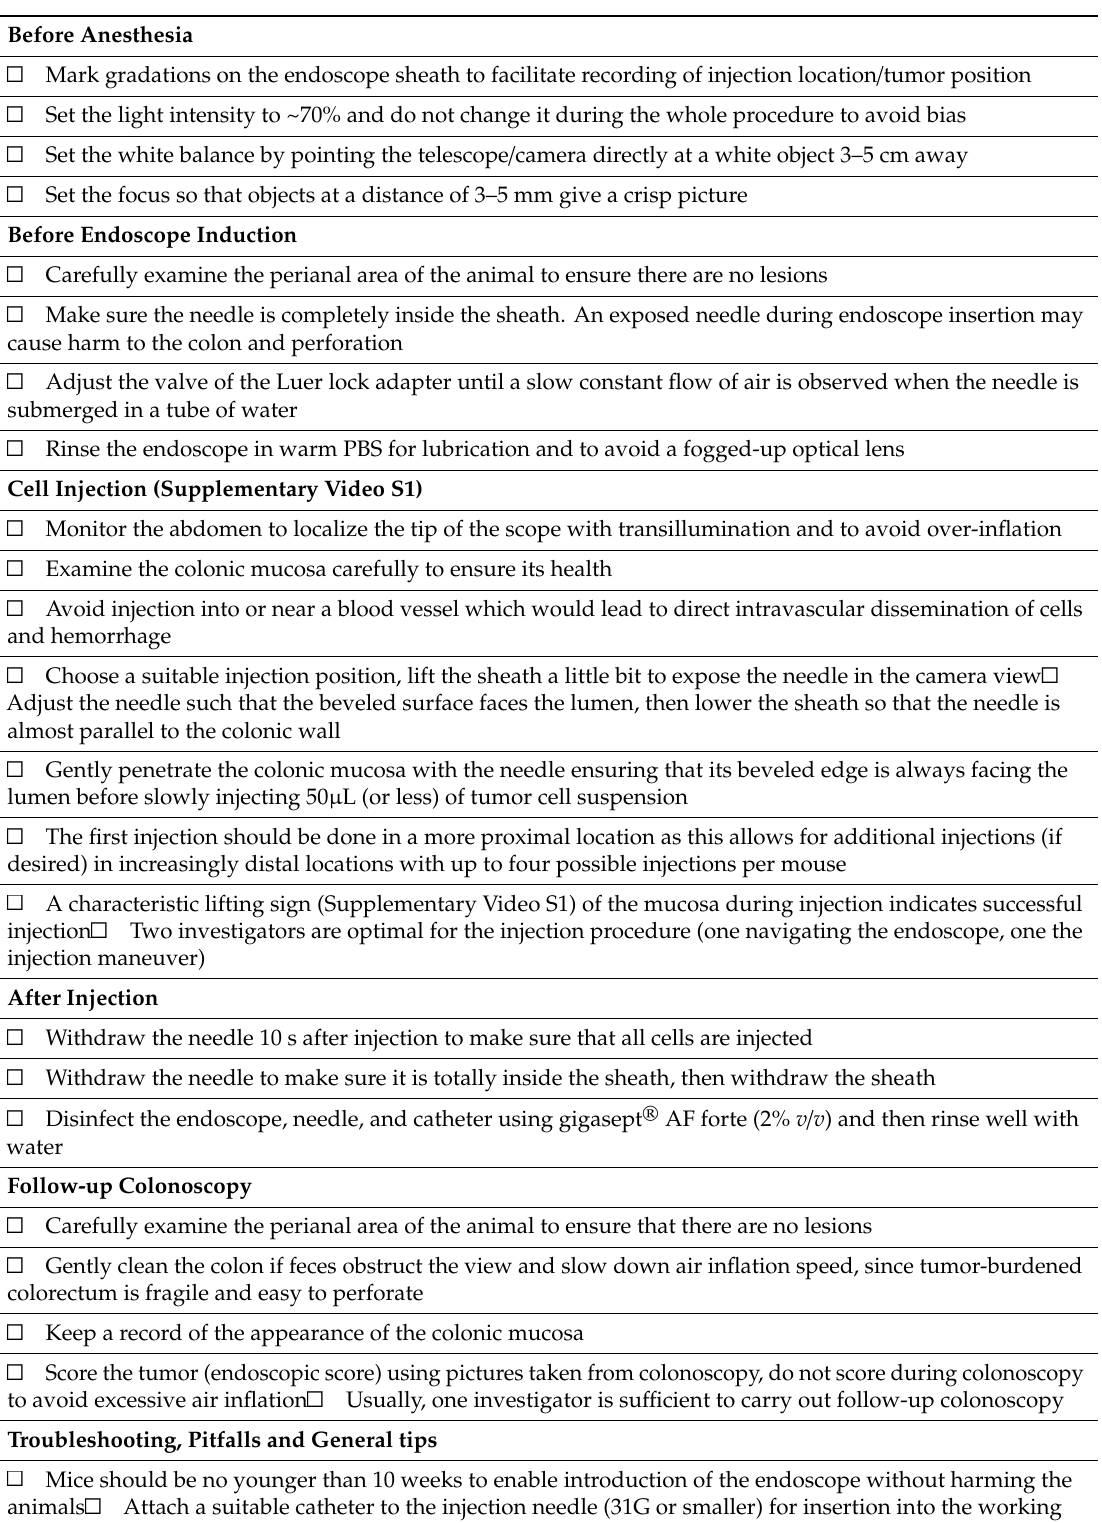
Table 3. Checklist of steps and tips for successful establishment of the current endoscopy-guided mouse model of colorectal